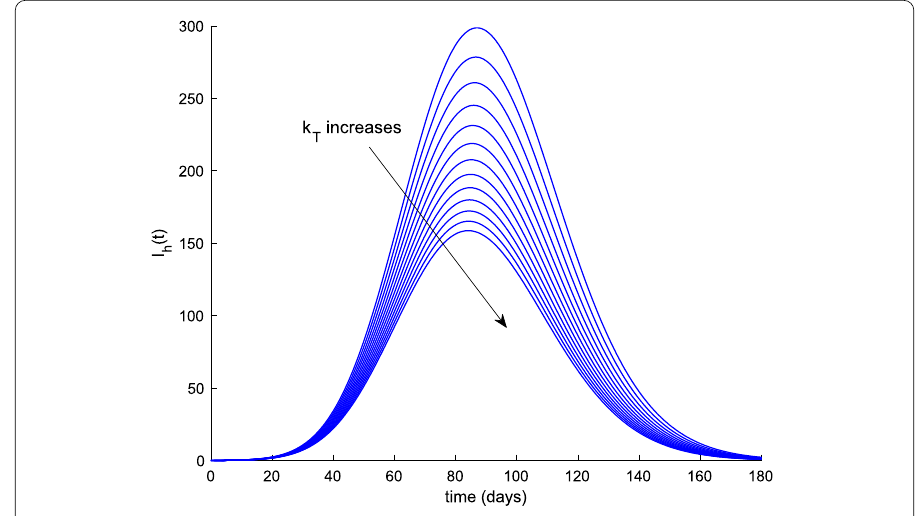
Figure 11 Effect of both actions, vaccination and treatment, on the evolution of hospitalized cases. The value of k V is fixed to k V = 0.001, and the value of k T varies from k T = 0.002 to k T = 0.008